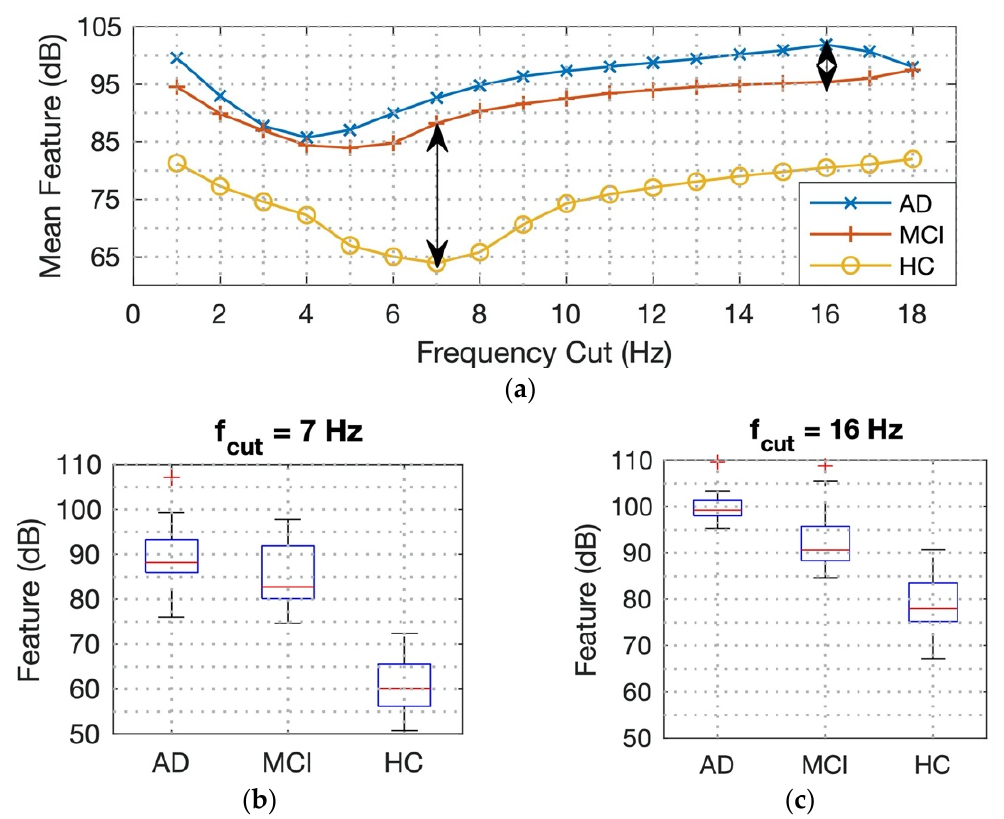
Figure 4. ( a ) The mean value of the feature extraction, the black double arrows, show the maximum distance between HC and AD + MCI for f cut = 7 Hz and between AD and MCI for f cut = 16 Hz. The statistical results are shown in ( b ) for 7 Hz and ( c ) for 16 Hz. In both of the last two graphs, the main box represents the data distribution, while the red line represents the median value, and the whisker stretches from the box show the range of the data, except for the outlays that are represented, such as the floating point (+).